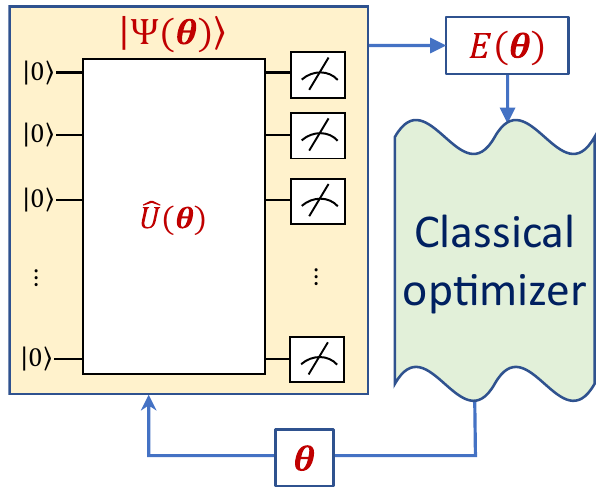
Fig. 2 Schematic illustration of the variational quantum eigensolver algorithm. Given an initial guess for the parameter vector θ , the many-body state is prepared using parametrized circuit ^ U ð θ Þ on the quantum computer. A set of measurements are performed on a computational basis to estimate the cost function E ( θ ), possibly including classical postprocessing for error mitigation. This value is subsequently passed to a classical optimizer. The parameters θ are then updated by the optimizer, which triggers a new iteration of state preparation and energy measurement. The cycle continues until E ( θ )